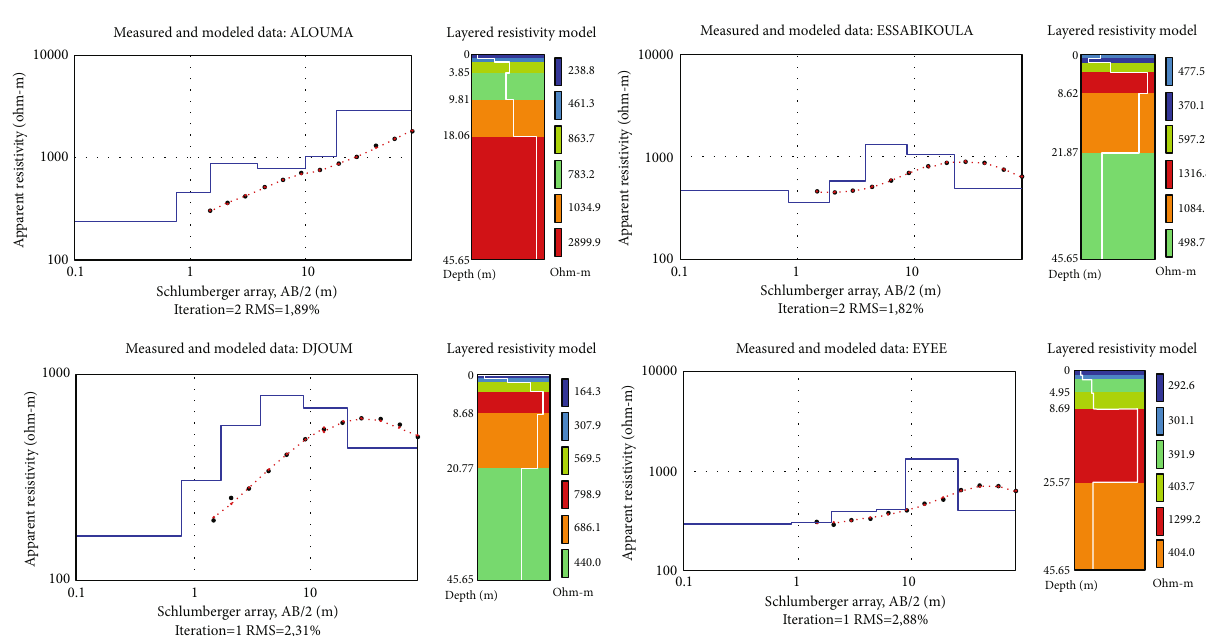
Figure 2: Geoelectrical sections in the green belt